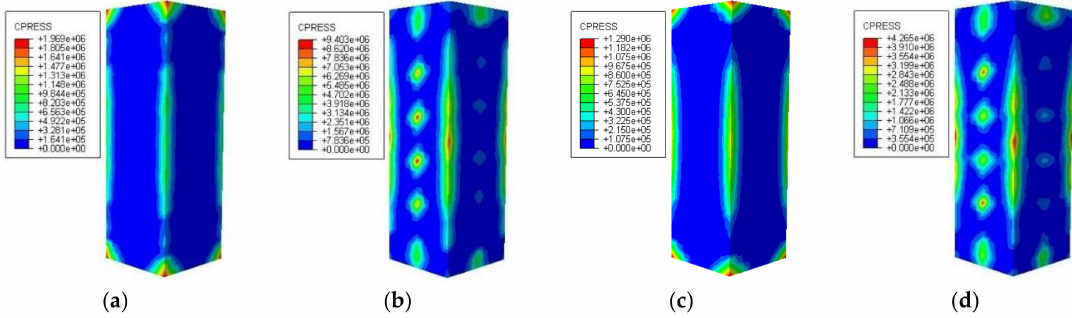
Figure 21. Distributions of the restraining force of steel tube to concrete ( a ) DS-200-REF; ( b ) DS-200; ( c ) DS-600-REF; ( d )